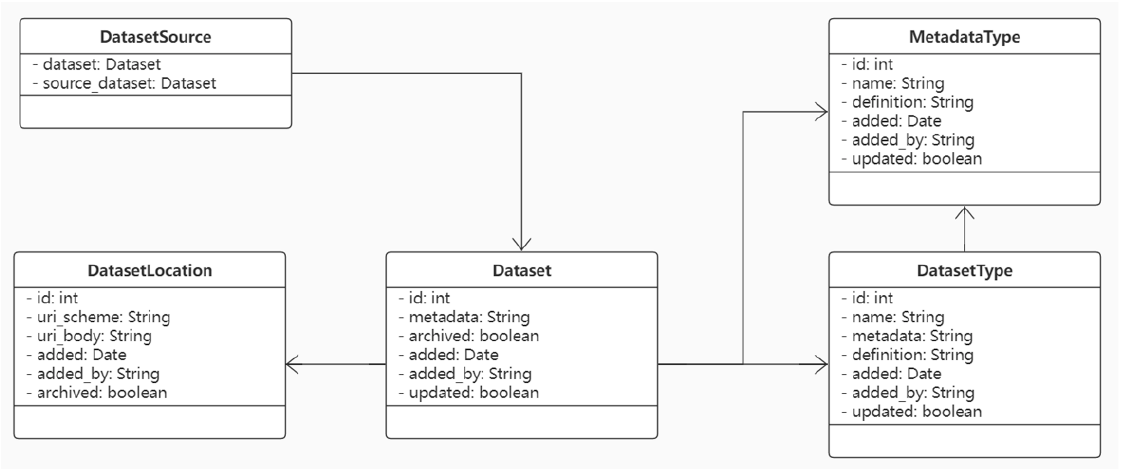
Figure 2. The UML diagram of the five-table ODC structure.